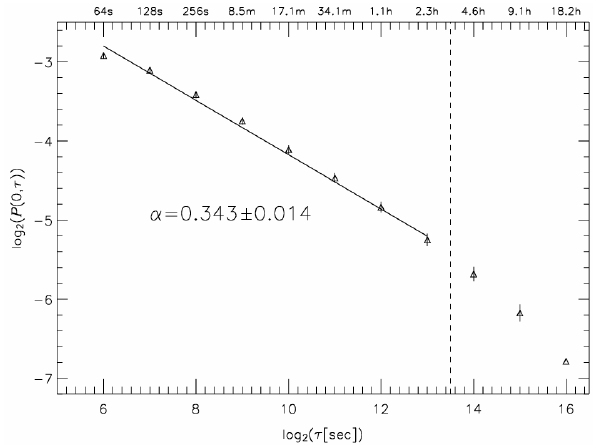
Fig. 7. Scaling of the PDF peaks, log 2 P (0, τ ) versus log 2 τ , for the δv sw curves shown in Fig. 6. The linear best fit to the data yields a slope of α 0 =0.343 ± 0.014 using a PDF bin size of 1kms − 1 . The error bars assume Gaussian noise in the peaks, and are drawn at the 3 σ level. The vertical dashed line indicates the nominal outer temporal scale for the power law regime.